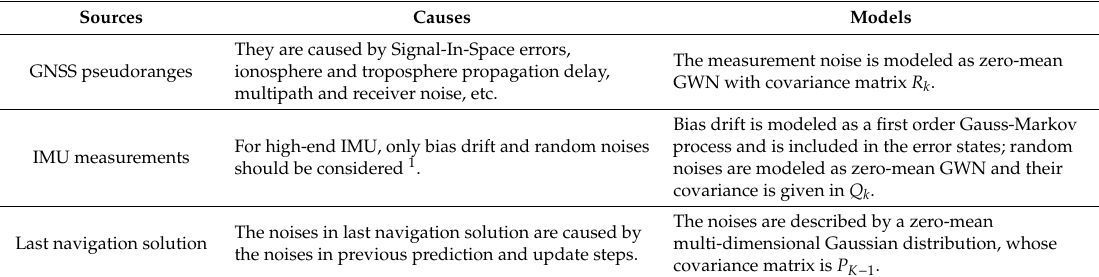
Table 1. Sources, causes, and models of the errors in the integration system.